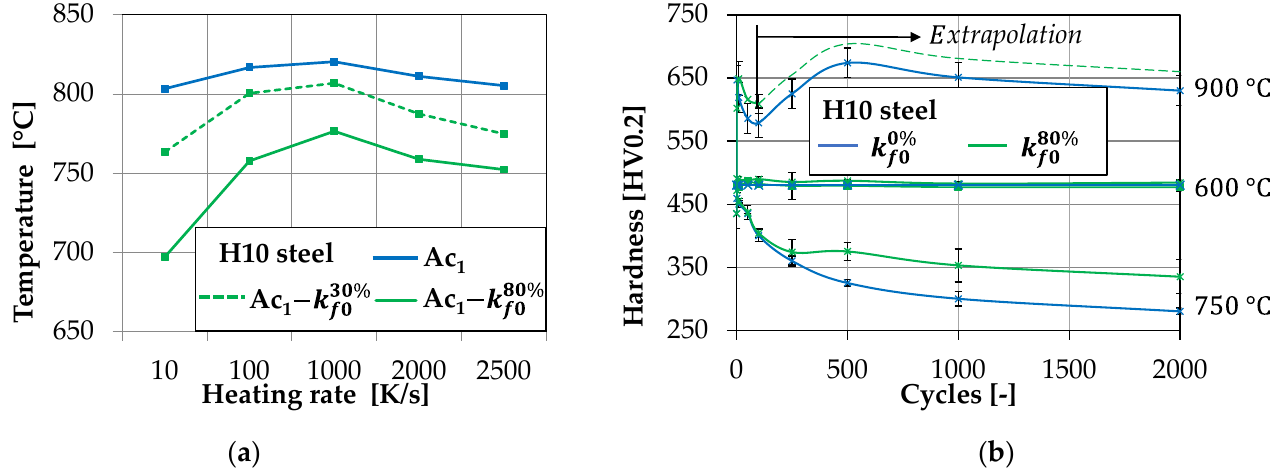
Figure 4. ( a ) A c1 temperature of H10 steel regarding heating rate and mech. stress superposition; ( b ) Hardness evolution of H10 steel obtained by laboratory testing.